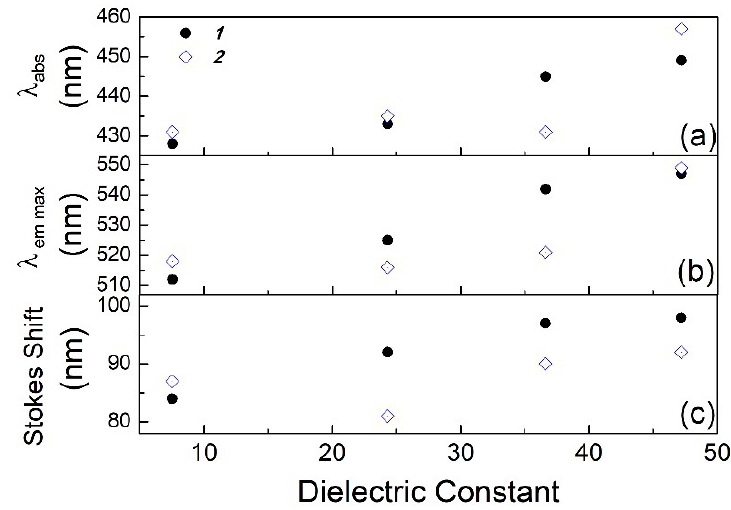
( a ), λ ( b ) and the Stokes shift ( c ) in function of the dielectric constant for Figure 3. λ abs em max Figure 3. λ abs ( a ), λ em max ( b ) and the Stokes shift ( c ) in function of the dielectric constant for compounds compounds 1 and 2 are presented for different solvents. 1 and 2 are presented for different